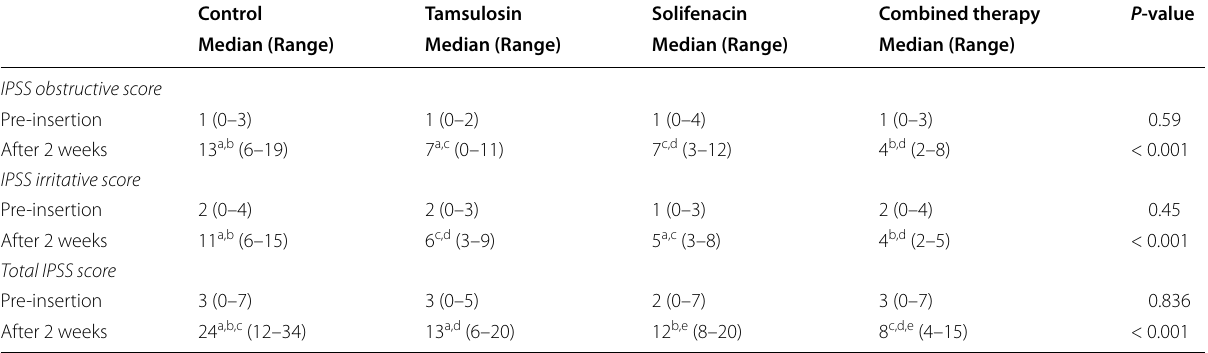
Similar letters (a, b, c, d, e) indicate significant difference IPSS International Prostate Symptom Score